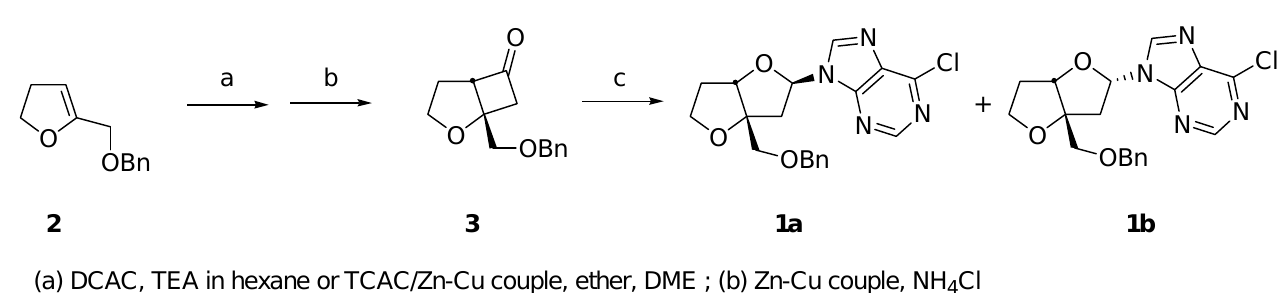
Scheme 2. Preparation of a Bicyclic Nucleoside